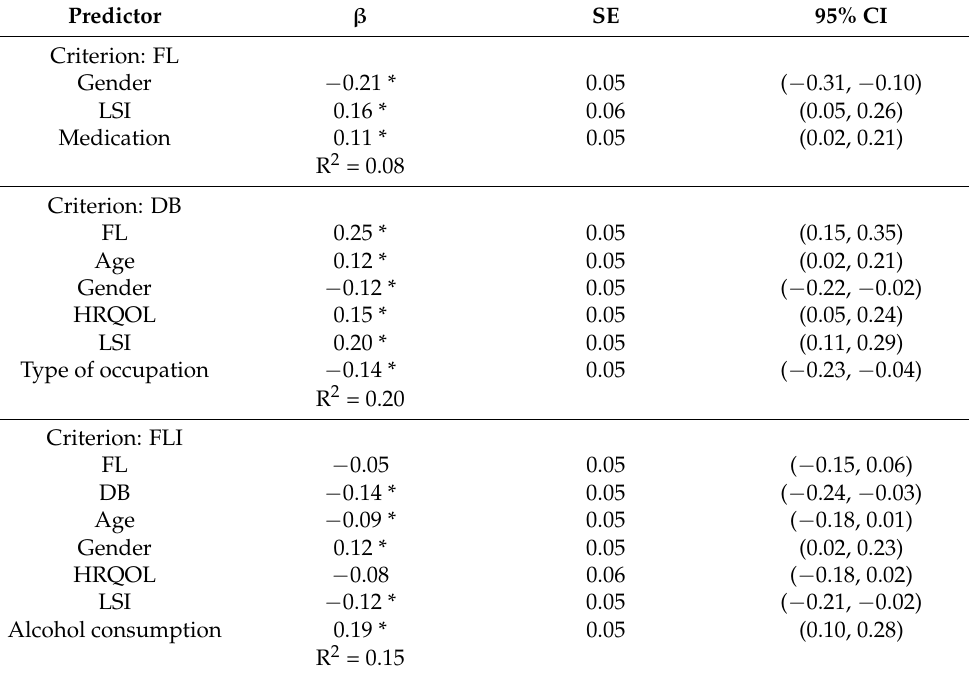
Table 3. Standardized path coefficients, SEs, and 95% CIs for the path analysis.